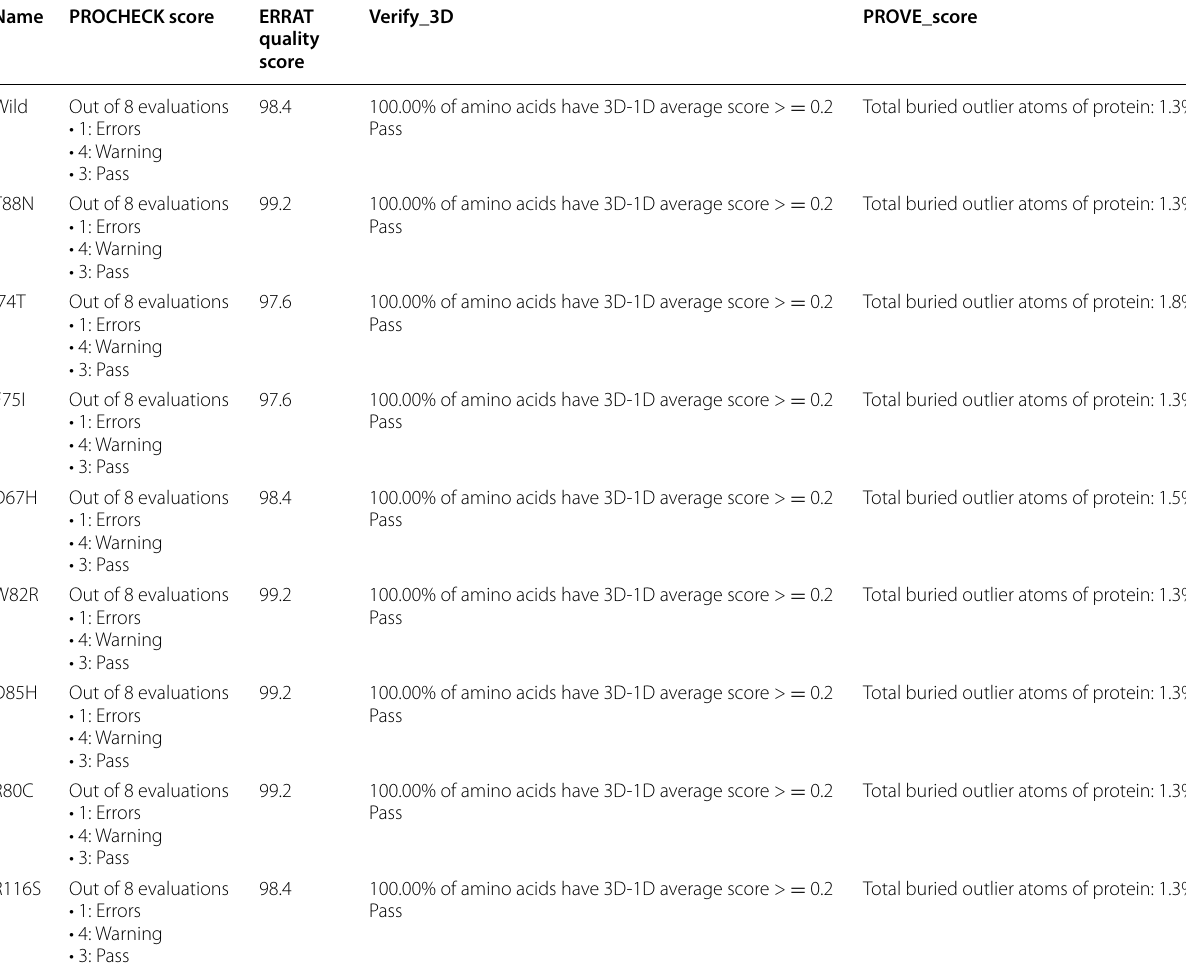
Table 6 3D structure evaluation by different online